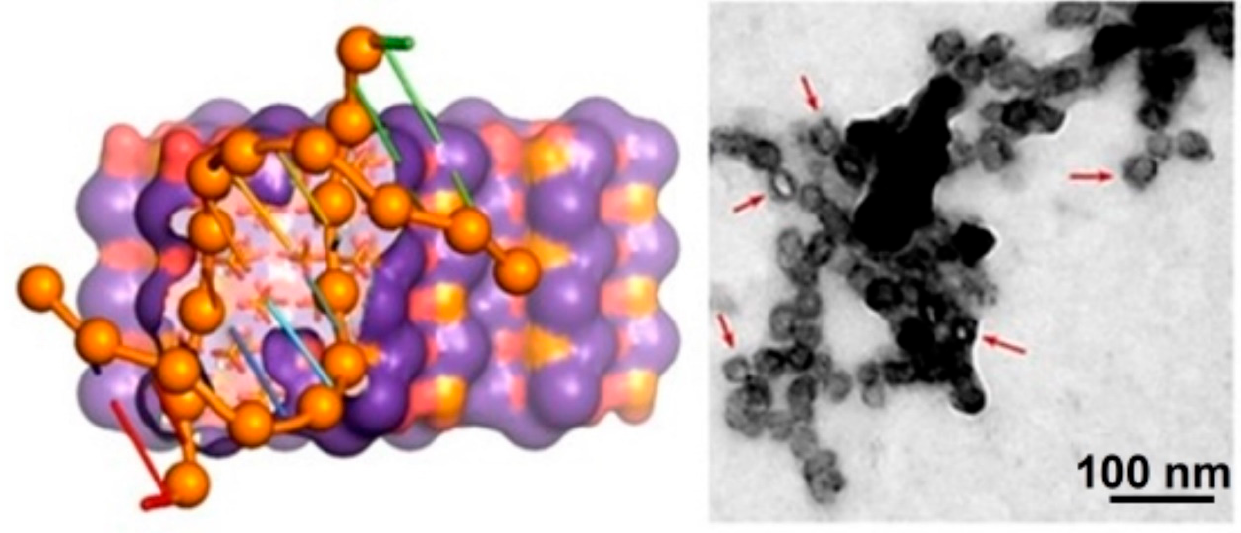
Figure 6. Scheme showing the incorporation of DNA inside the HAp structure ( left ) and TEM micrograph showing nanoparticles (red arrows) that incorporate DNA ( right ). Reproduced with permission from [48,49].